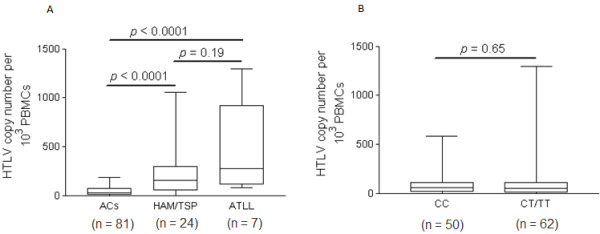
Distribution of HTLV-1 proviral load levels among study subjects. (A) Box and Whiskers plot of HTLV-1 proviral load in asymptomatic HTLV-1 carriers, HTLV-1–associated myelopathy/tropical spastic paraparesis patients and Adult T Cell Leukemia/Lymphoma. (B) Interleukin 28B CC versus CT/TT allelic variants.